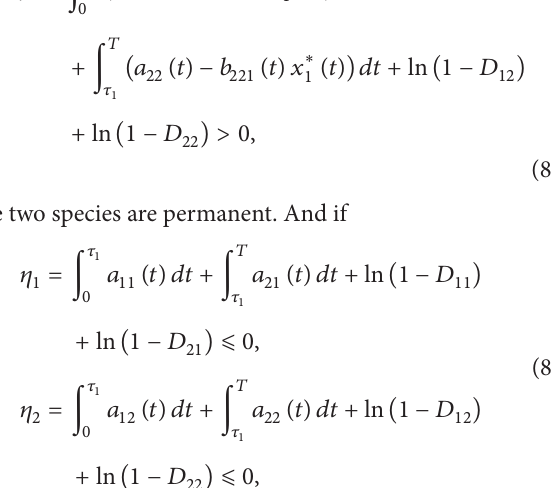
Figure 4: The trends of 𝑓(𝐷 1 ) on 𝐷 1 (a) and 𝑔(𝐷 2 ) on 𝐷 2 (b). Obviously, 𝑓(𝐷 1 ) ⩽ 0 if 0.6453 ⩽ 𝐷 1 < 1 and 𝑔(𝐷 2 ) ⩽ 0 if 0.4598 ⩽ 𝐷 2 < 1 . 𝜏 𝛾 = ∫ 2